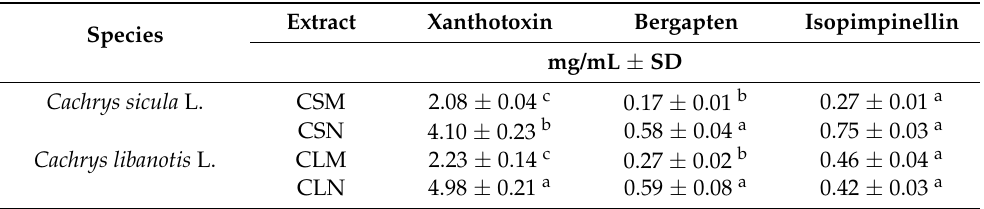
Table 3. Quantitative analysis of identified furanocoumarins.